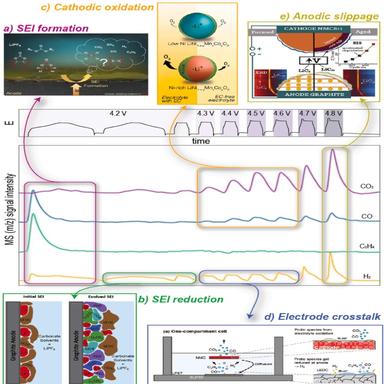
.1. Operando gas analysis data (OEMS) showing voltage profile (top) alongside typical gas evolution profiles (bottom; m/z = 2 for H2; m/z = 27 for C2H4; m/z = 28 for CO; m/z = 44 for CO2) of electrochemical processes contributing to the formation/evolution of interfaces in LIBs. Cell composition: NMC811|LP57|G, from I. Temprano, unpublished data. Gas evolution events related to notable studies in the LIB literature: (a) SEI formation during initial cycle; (b) Reduction of SEI components (#pag